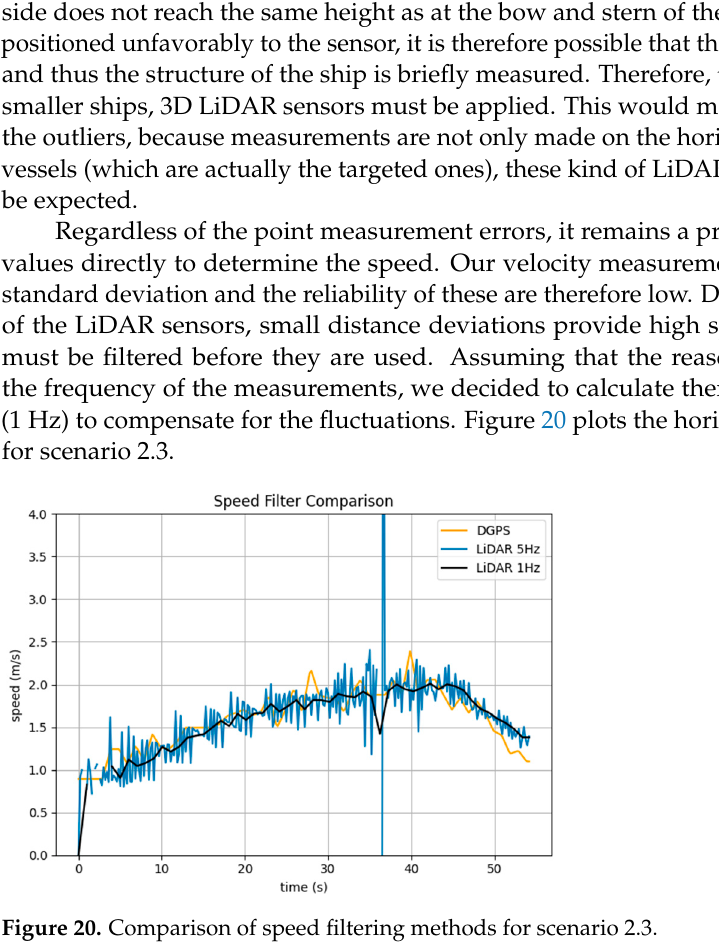
Figure 20. Comparison of speed filtering methods for scenario 2.3. The DGPS measures velocity in 1 Hz intervals, with measurements based on